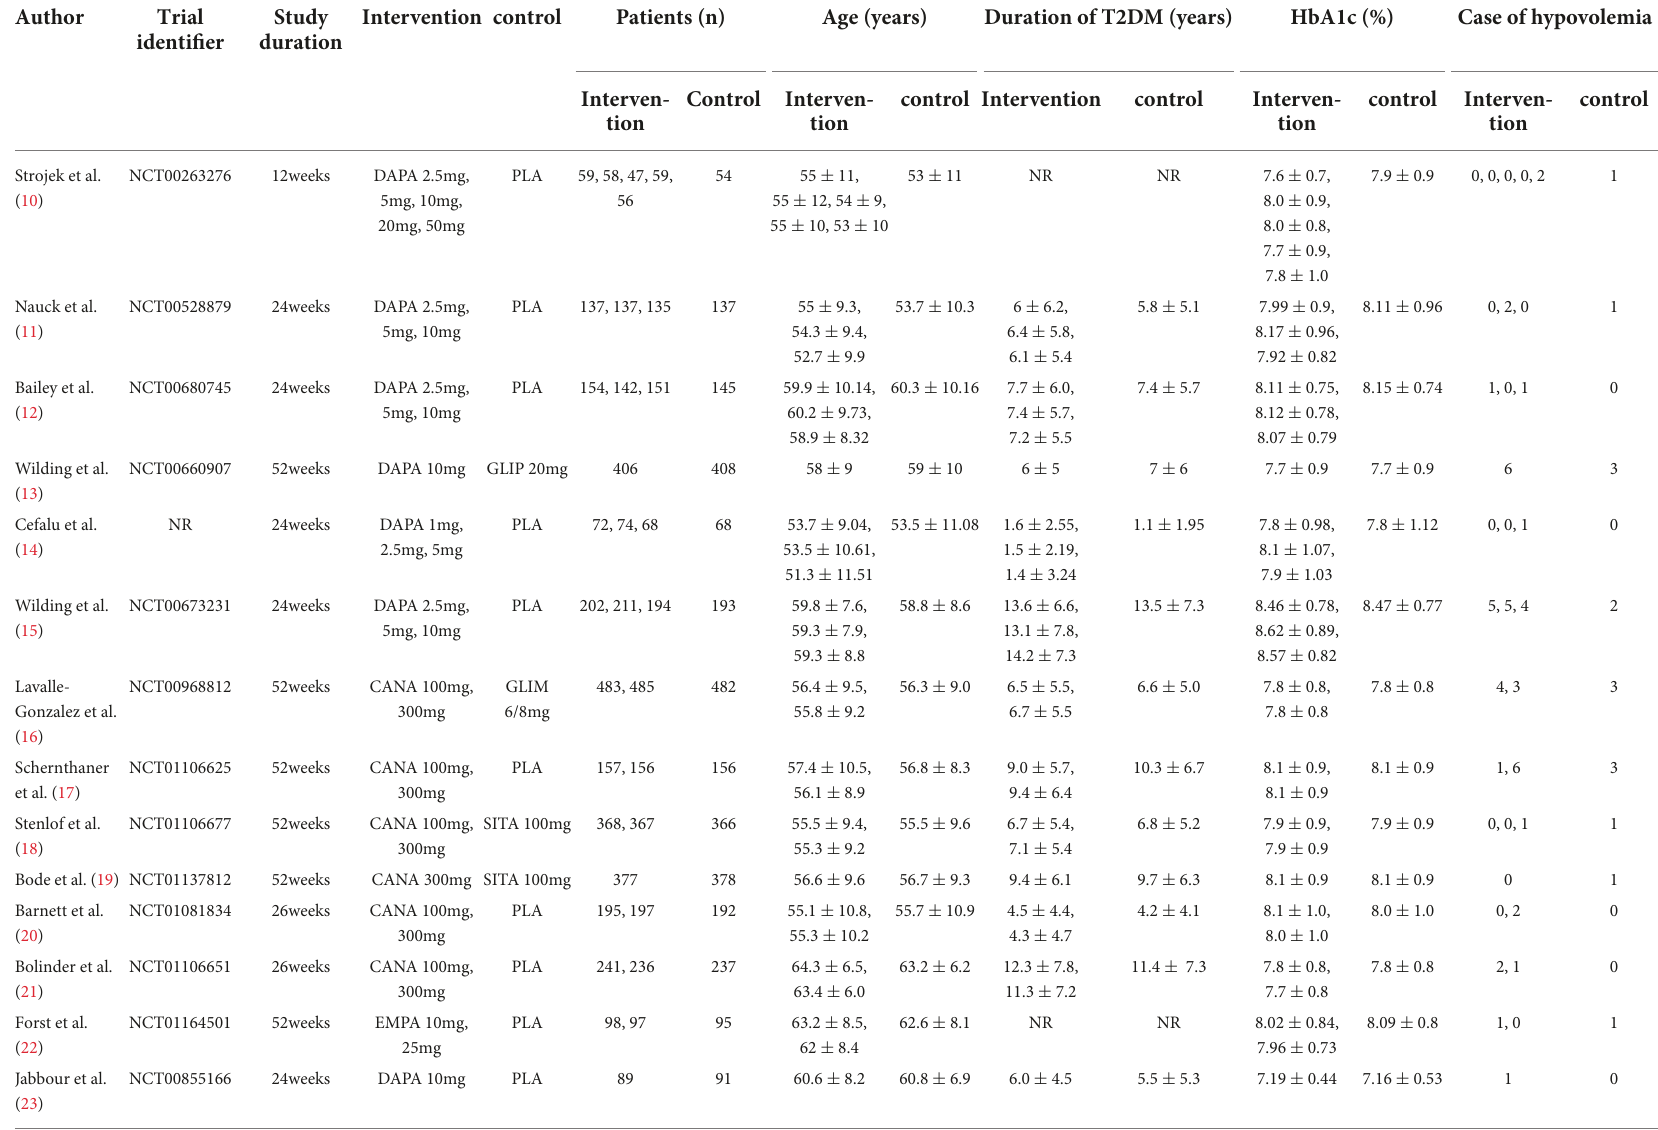
TABLE 1 Characteristics of the randomized controlled studies (RCTs) included in the